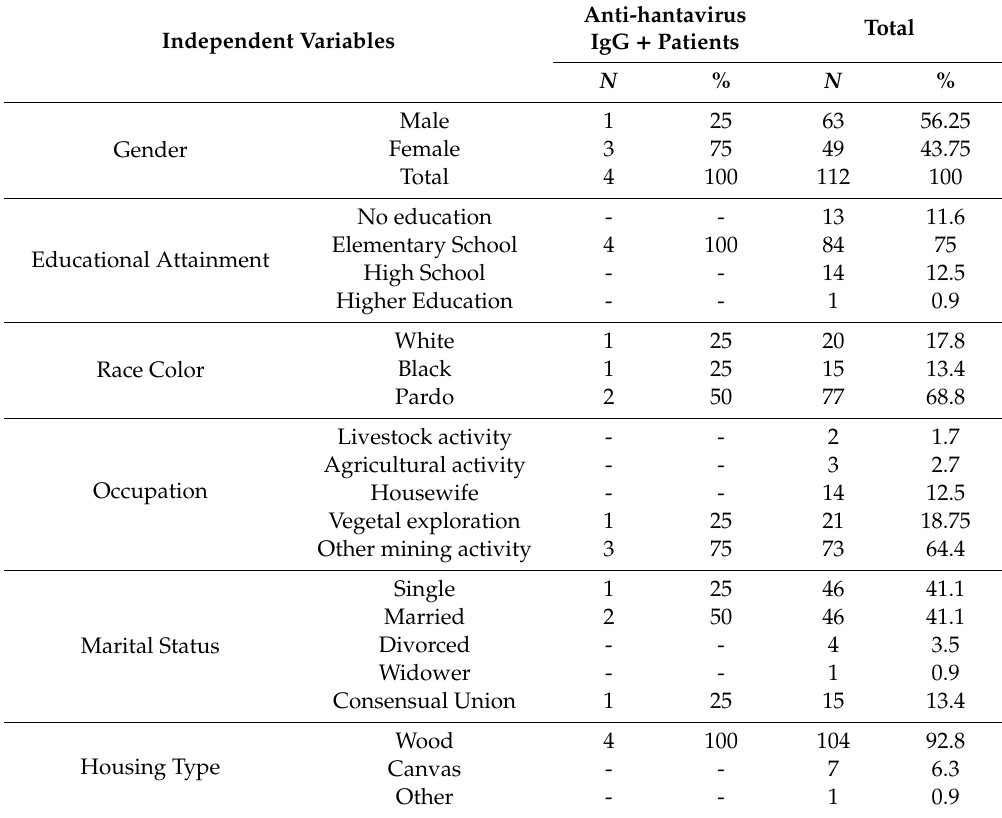
Table 1. The socio-demographic characteristics of 112 residents of Tr ê s Fronterias, state of Mato Grosso, Brazil,